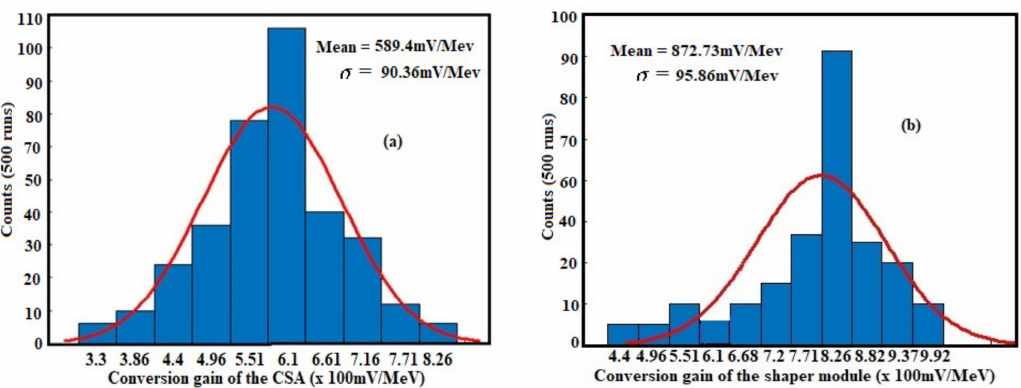
Figure 18. Histograms of the conversion gain for both ( a ) the CSA and ( b ) the